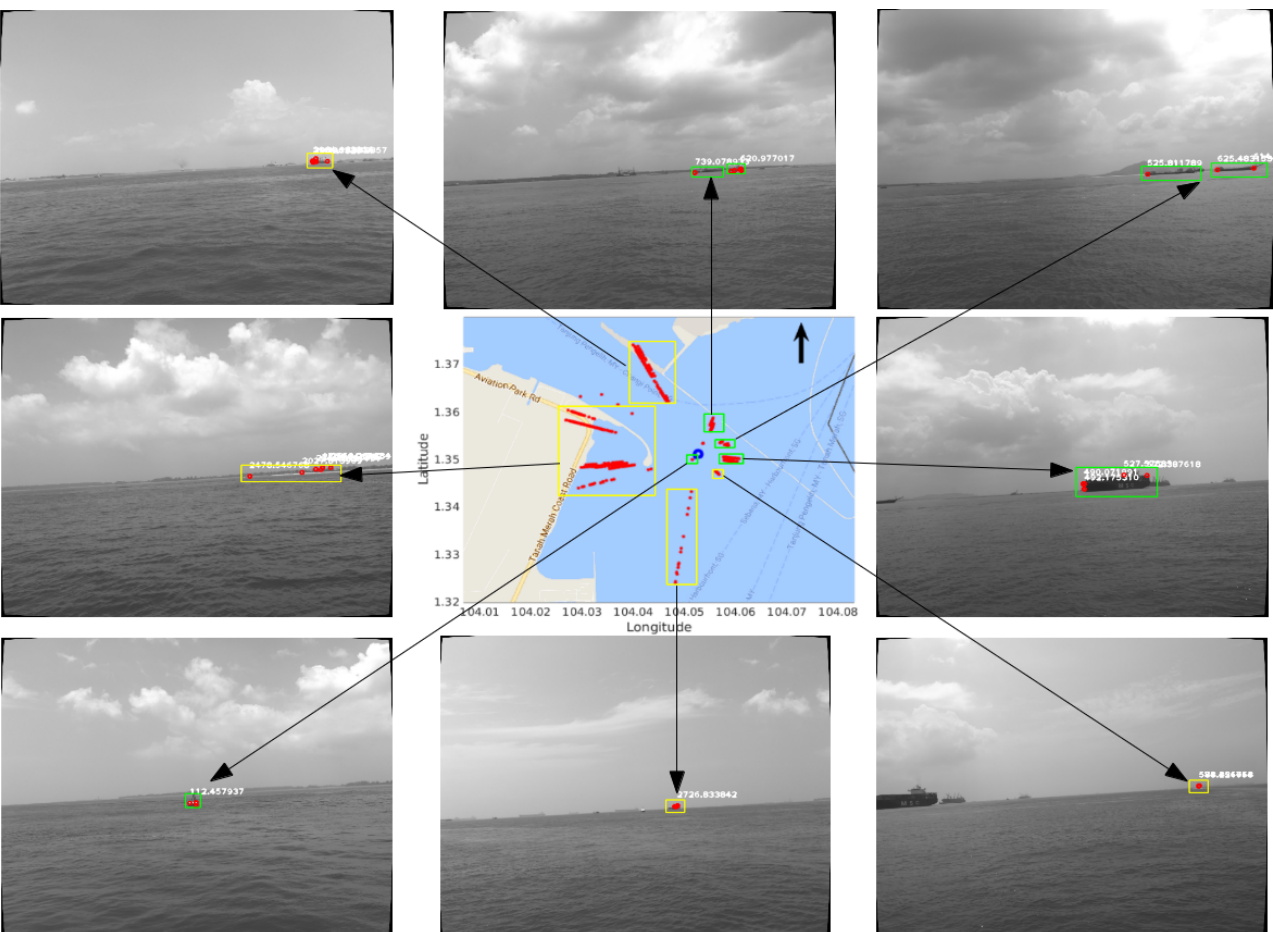
Figure 11. The resulting obstacle map (middle) after a full moving loop of the USV (Seq-3). The corresponding obstacles in the original images are shown in the surrounding figures with an arrow linking each of them to the map. In the obstacle map, the blue circle represents the trajectory of the USV, and the red points represent the mapped feature points from the obstacles. The green rectangles are manually drawn to illustrate the stationary obstacles, while the yellow rectangles are manually drawn to show the distant obstacles with large mapping variances and the moving